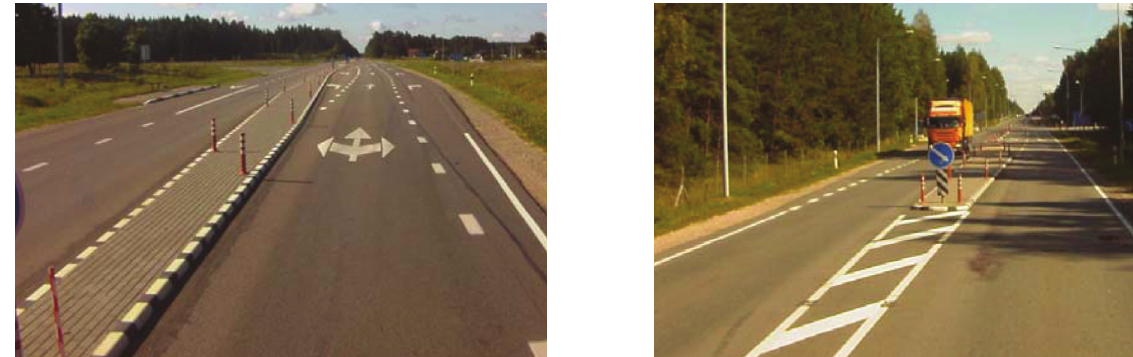
Fig. 4. Raised splitter islands in 47.88 km and 61.14 km of the main road A11 Šiauliai–Palanga